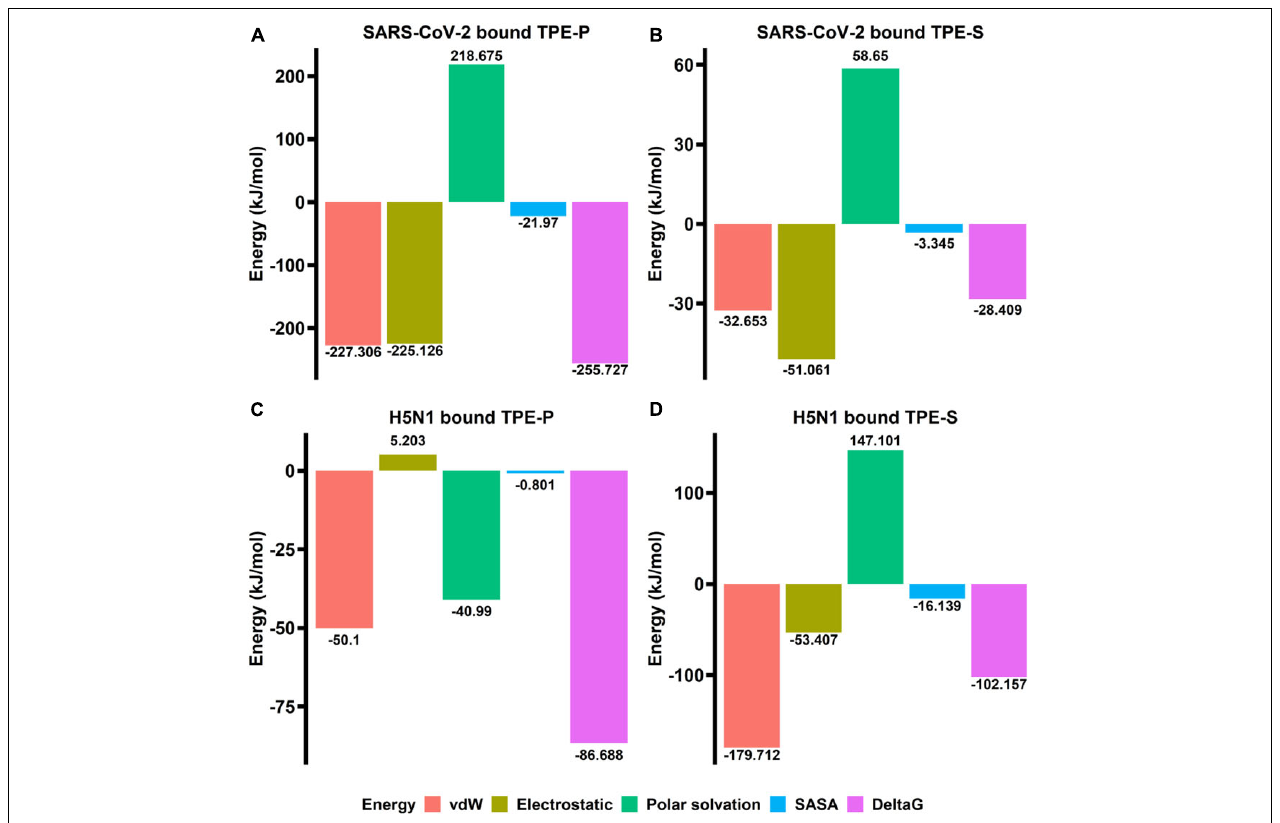
FIGURE 4 | The bar plots (A–D) indicating the free energy components (vdW, electrostatic, polar surface, SASA, and (cid:49) G) obtained from MM-PBSA calculations relative to TPE-P and TPE-S bound to SARS-CoV-2 ACE2-binding domain and H5N1 hemagglutinin protein. The energy values are shown in